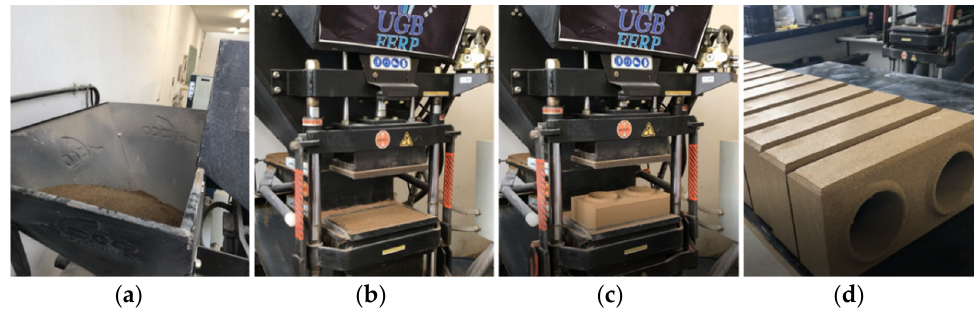
Figure 4. ( a ) Loading box; ( b ) mold box; ( c ) demolding; ( d ) soil‒cement brick.